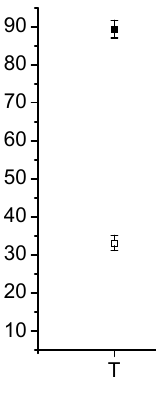
Figure 5. Intermetallic layer at a half of thickness in the welds cross sections of joints 1T ( a ), 1B ( c ), 3T ( b ) and 3B ( d ).